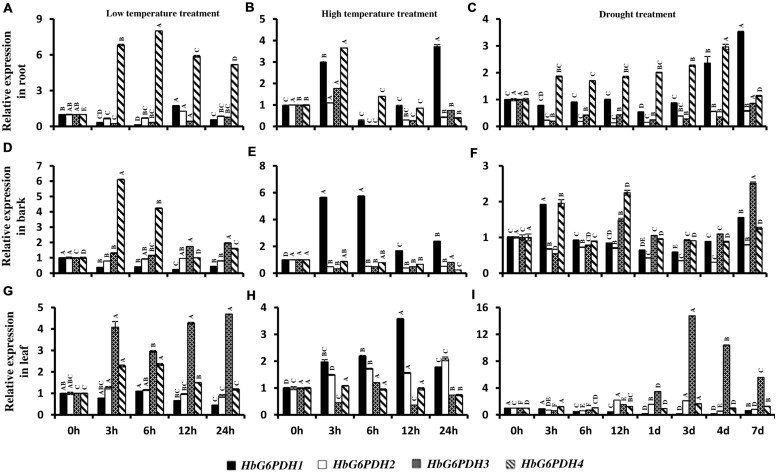
Expression of HbG6PDH isoforms in the root, bark, and leaves in response to various stress treatments, viz. low temperature (A,D,G), high temperature (B,E,H) and drought (C,F,I). Readings are expressed as values relative to the unstressed control. Different capital letters indicate a significant difference at 0.01 level among different samples for the same gene.